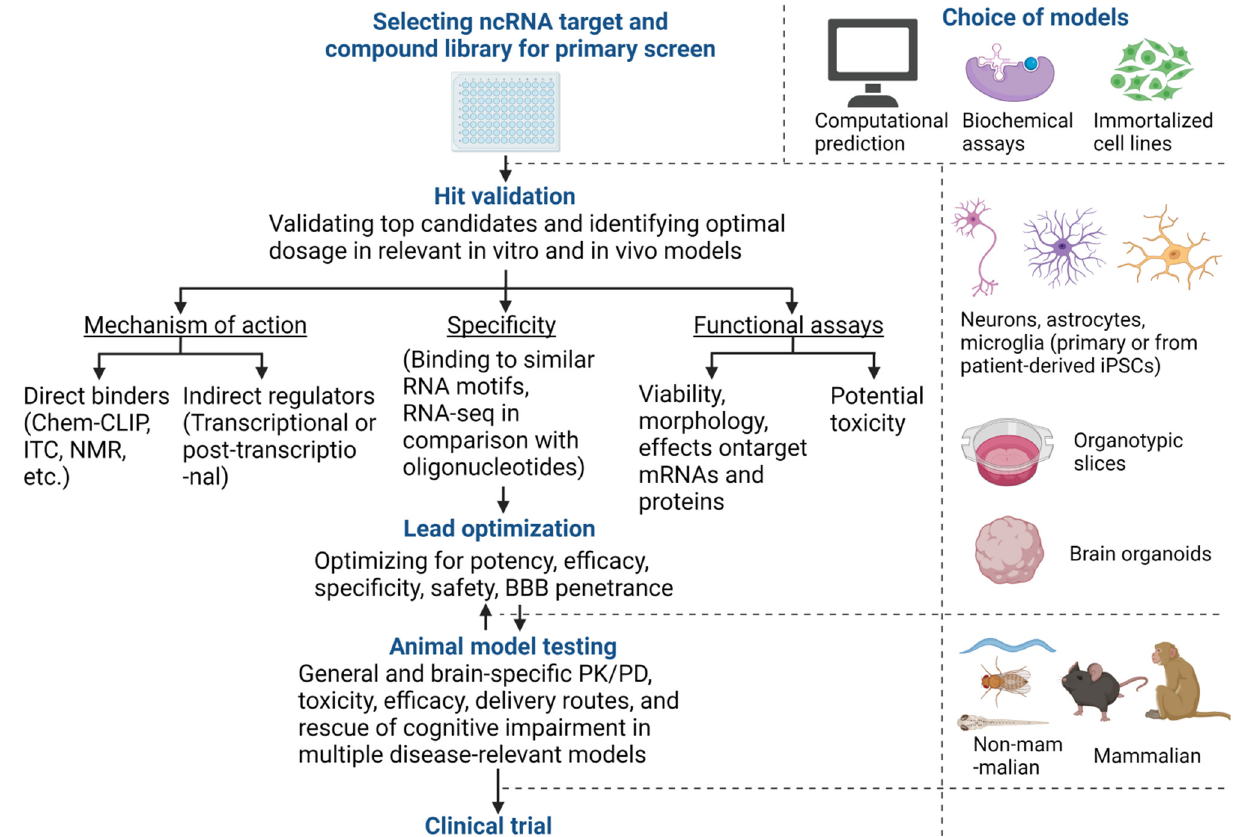
Figure 2. Preclinical discovery workflow for therapeutic small molecules targeting ncRNAs. This figure briefly outlines the workflow for discovering and validating small molecules targeting ncRNAs, with the recommended cellular and animal models at various steps on the right. The workflow starts with selecting an ADRD-relevant ncRNA target, a compound library, and a screening method. The size of the compound library, from a few hundred to millions of small molecules, will depend on various factors, including cost and estimated hit rate. For convenience and cost concerns, the primary HTS can be performed computationally, in biochemical assays with synthetic ncRNAs and small molecules, in immortalized cell lines, or, if possible, in ADRD-relevant cellular models. Once several candidates of small molecules have been identified from the primary screen, they should be validated in ADRD-relevant cellular models, including primary cells from animal models, cells differentiated from patient-derived iPSCs, organotypic brain slices, and brain organoids. An optimal dose that maximally modulates the ncRNA target should first be established. Subsequently, the mechanism of action, the specificity of action, and the functional efficacy and potential toxicity of each candidate small molecule can be investigated. Small molecules that specifically modulate the target ncRNA and its downstream targets and show neuroprotective effects with minimal toxicity can be further optimized with medicinal chemistry for improved potency, efficacy, safety, and BBB penetrance. Next, these improved small molecules can be tested for evidence of efficacy at the cellular and behavioral levels in multiple animal models of ADRD, followed by further chemistry optimization as needed. Finally, a small molecule with specific ncRNA target engagement, satisfactory brain PK/PD, good safety, and evidence of efficacy in animal models may be able to progress to human clinical trials. Abbreviations: Chem-Clip: Chemical Cross-Linking, and Isolation